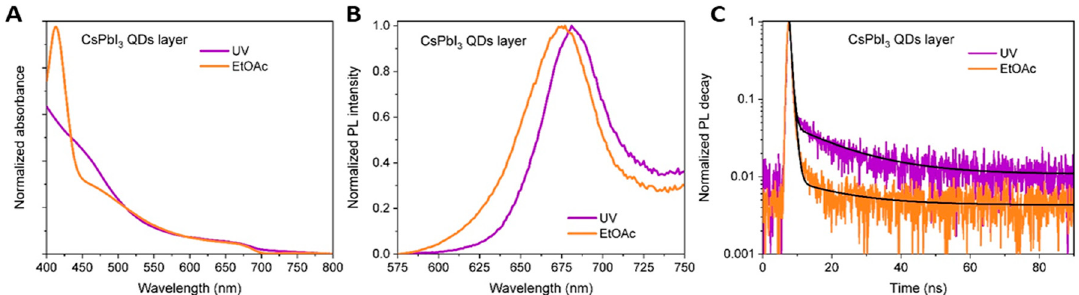
Figure 7. Optical characterization of CsPbI 3 QDs 3 stacked layers deposited on glass with and without UV treatment. ( A ) Normalized absorption spectra, ( B ) steady state PL emission spectra, excitation wavelength 530 nm, and ( C ) time resolved PL decay fitted whit a biexponential decay function.